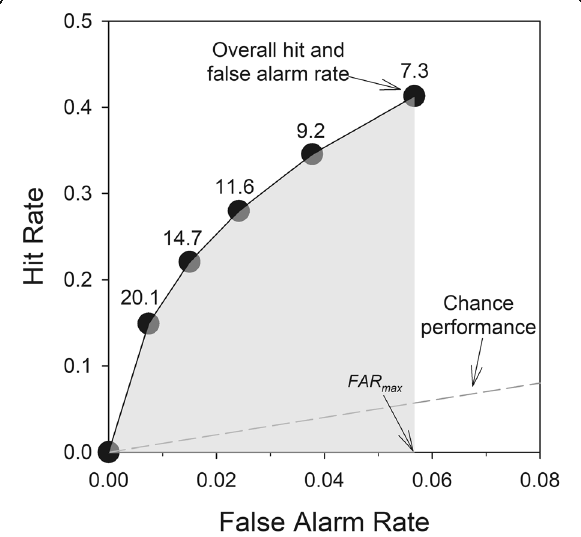
Fig. 4 Hypothetical receiver operating characteristics (ROC) curve for a lineup procedure in which a 5-point confidence scale was used. The number above each point is the diagnosticity ratio for that correct and false positive identification (ID) rate pair. The region shaded in light gray represents the partial area under the ROC curve (pAUC) for the specified false ID rate range of 0 to FAR max , which is equal to .057 in this case. The diagonal line represents chance performance (where correct ID rate = false ID